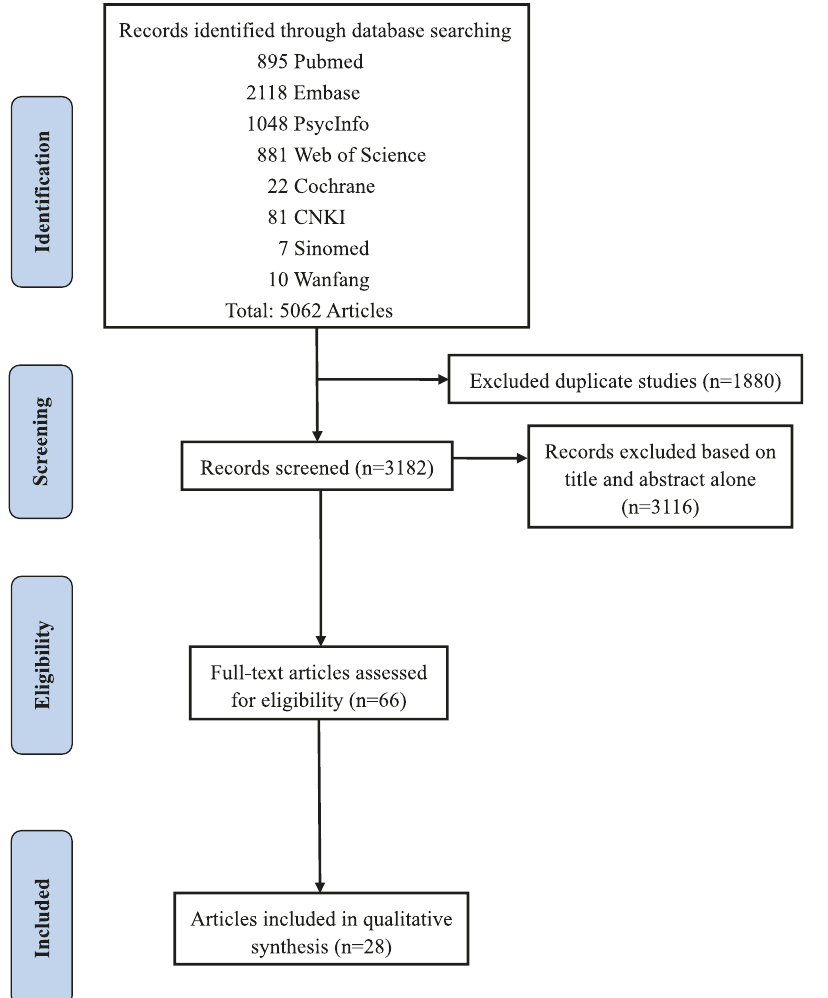
Fig. 1 Flow chart of literature identi fi cation and